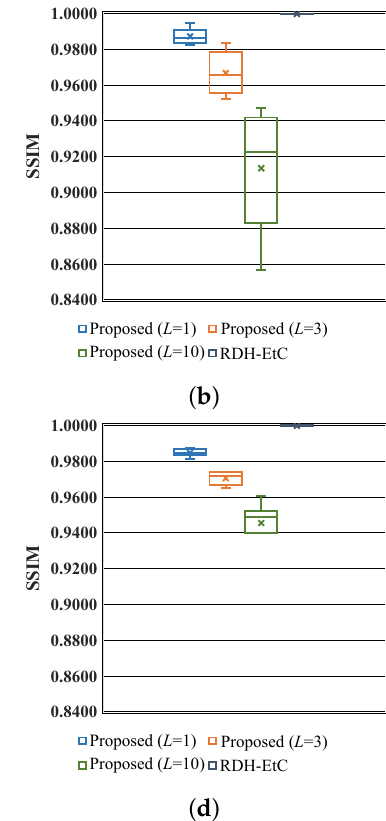
Figure 16. Marked-image quality of proposed and RDH-EtC [30] methods (SSIM). ( a ) Kodim4; ( b ) peppar; ( c ) ihc5 (1/16); ( d ) ihc5